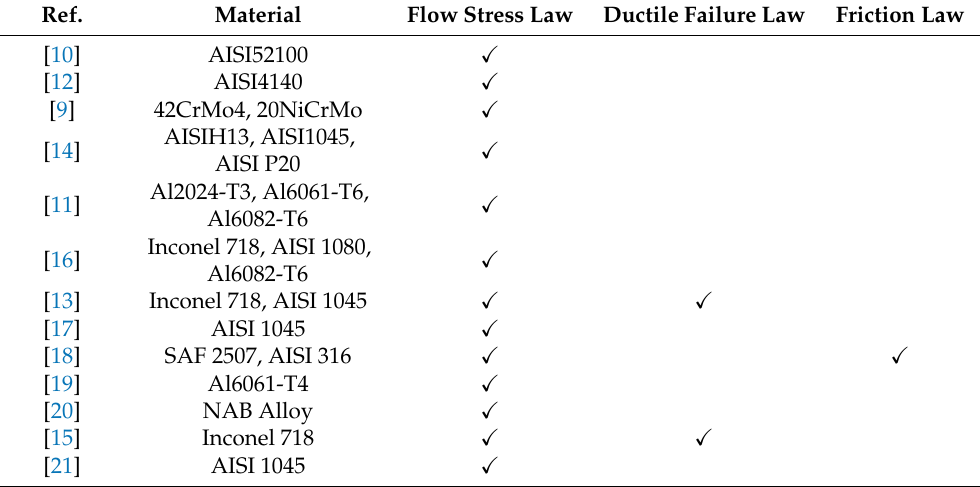
Table 3. Materials employed for the inverse simulation in orthogonal machining and the improved law. Ref.